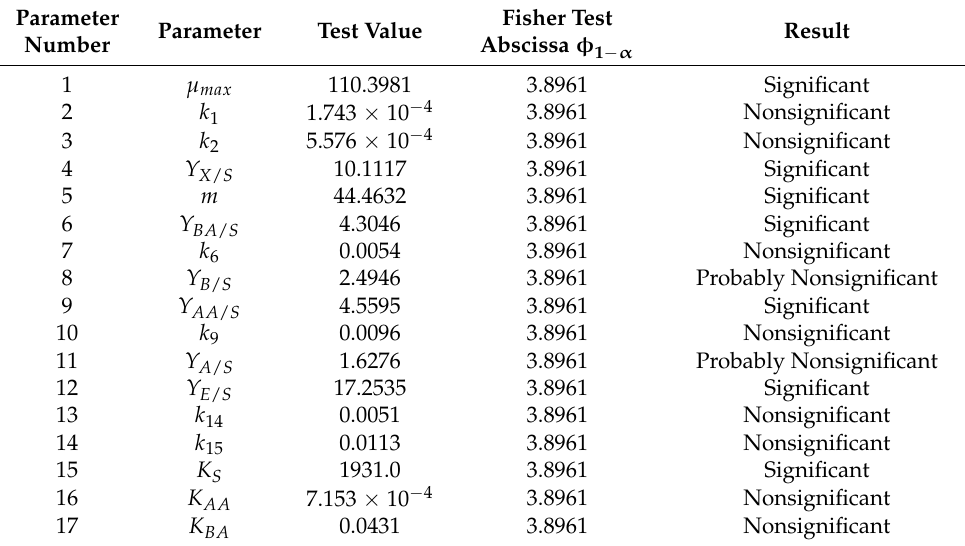
Figure 2. Correct parameters confidence interval with 95% probability for the Base-Model with 17 parameters. Table 4. Fisher F test results for the 17 parameters of the